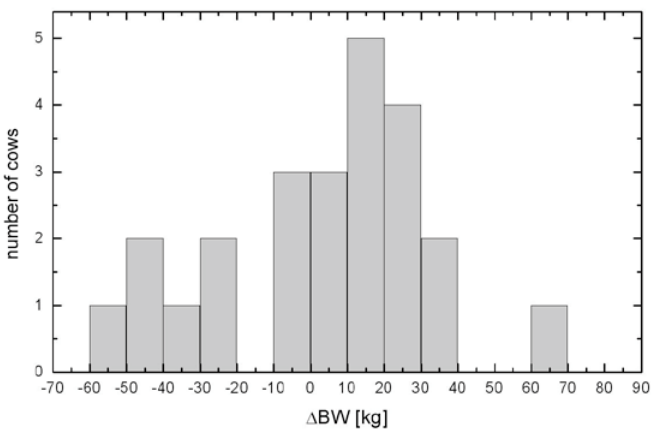
Figure 1 Distribution of differences ΔBCS=BCS2−BCS1 (BCS2: BCS level at second sampling, BCS1: BCS level at first sampling)